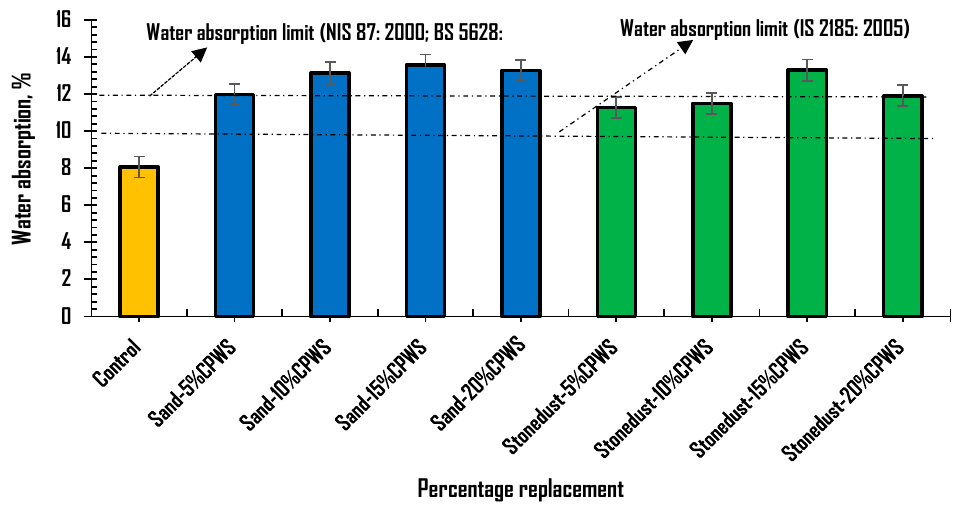
Figure 6. Water absorption rate of sandcrete block samples with CPWS as sand and stone dust re- placement.